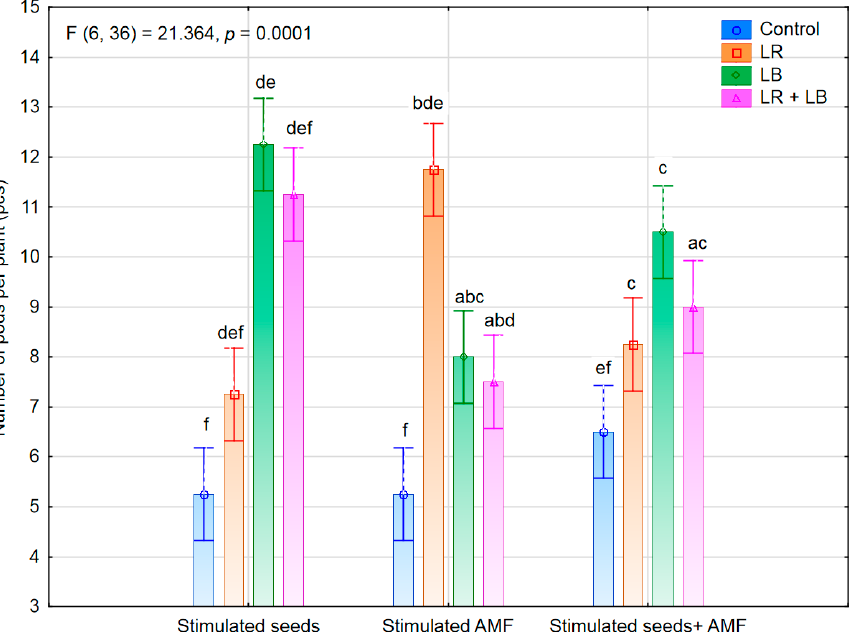
Figure 2. Effect of the interactions of the factors on the pod number per plant. Different letters indicate the significant differences at p < 0.05.